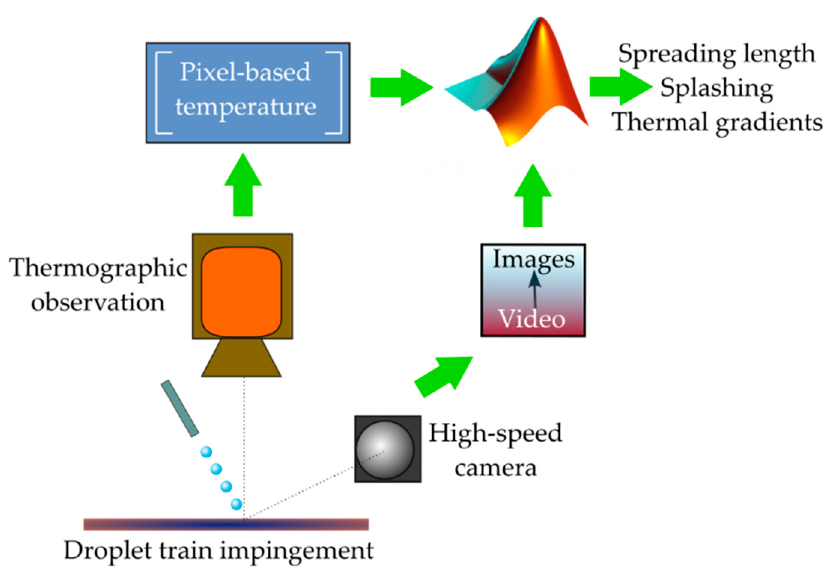
Figure 2. Image and data analysis steps of the study.